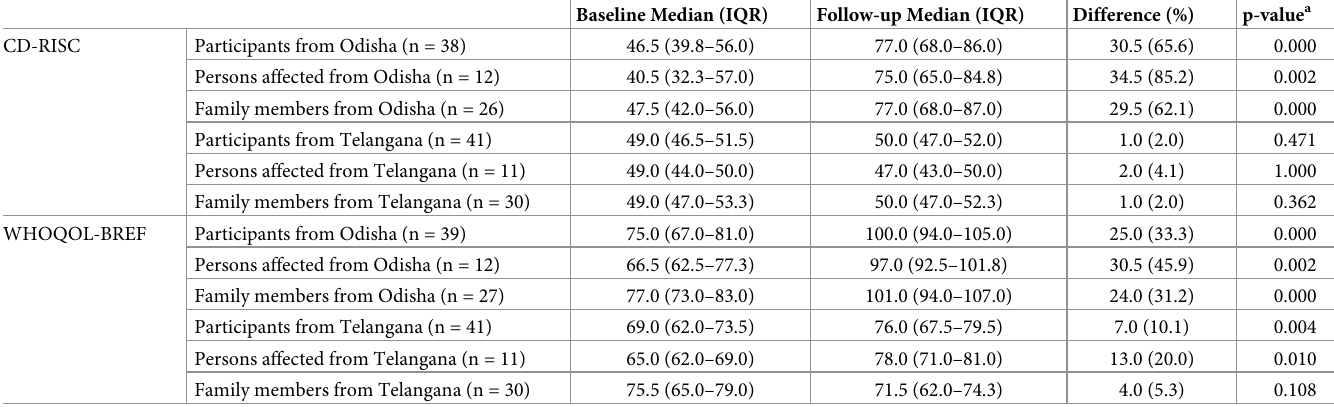
Table 2. Difference in baseline and first follow-up in resilience scores (CD-RISC) and quality of life scores